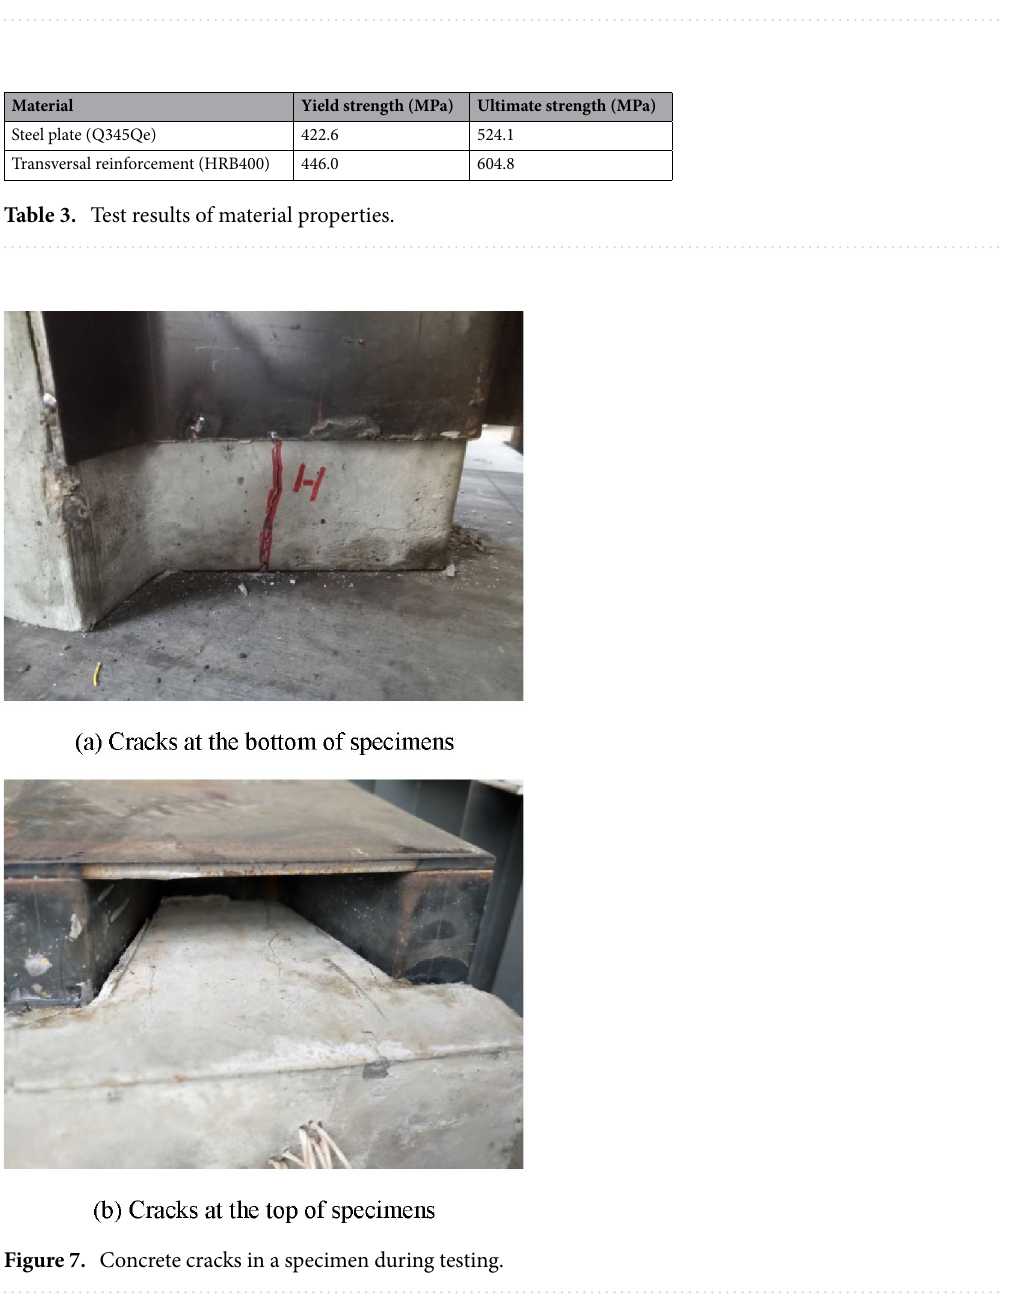
Figure 6. Load setup of specimens.